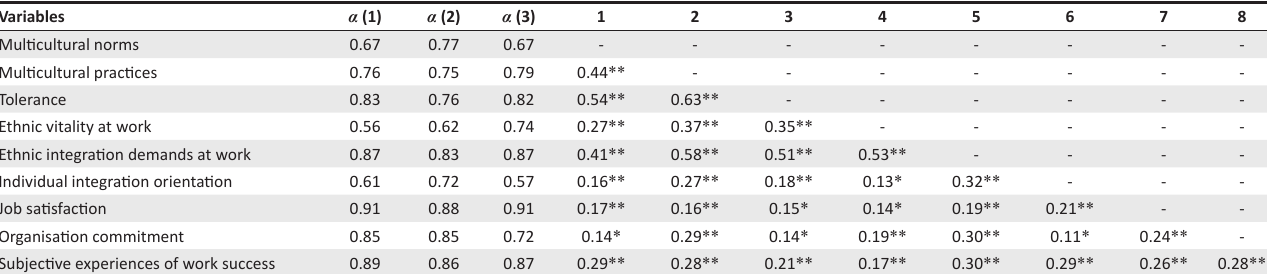
TABLE 2: Descriptive statistics and correlations between multiculturalism and integration characteristics and outcomes.